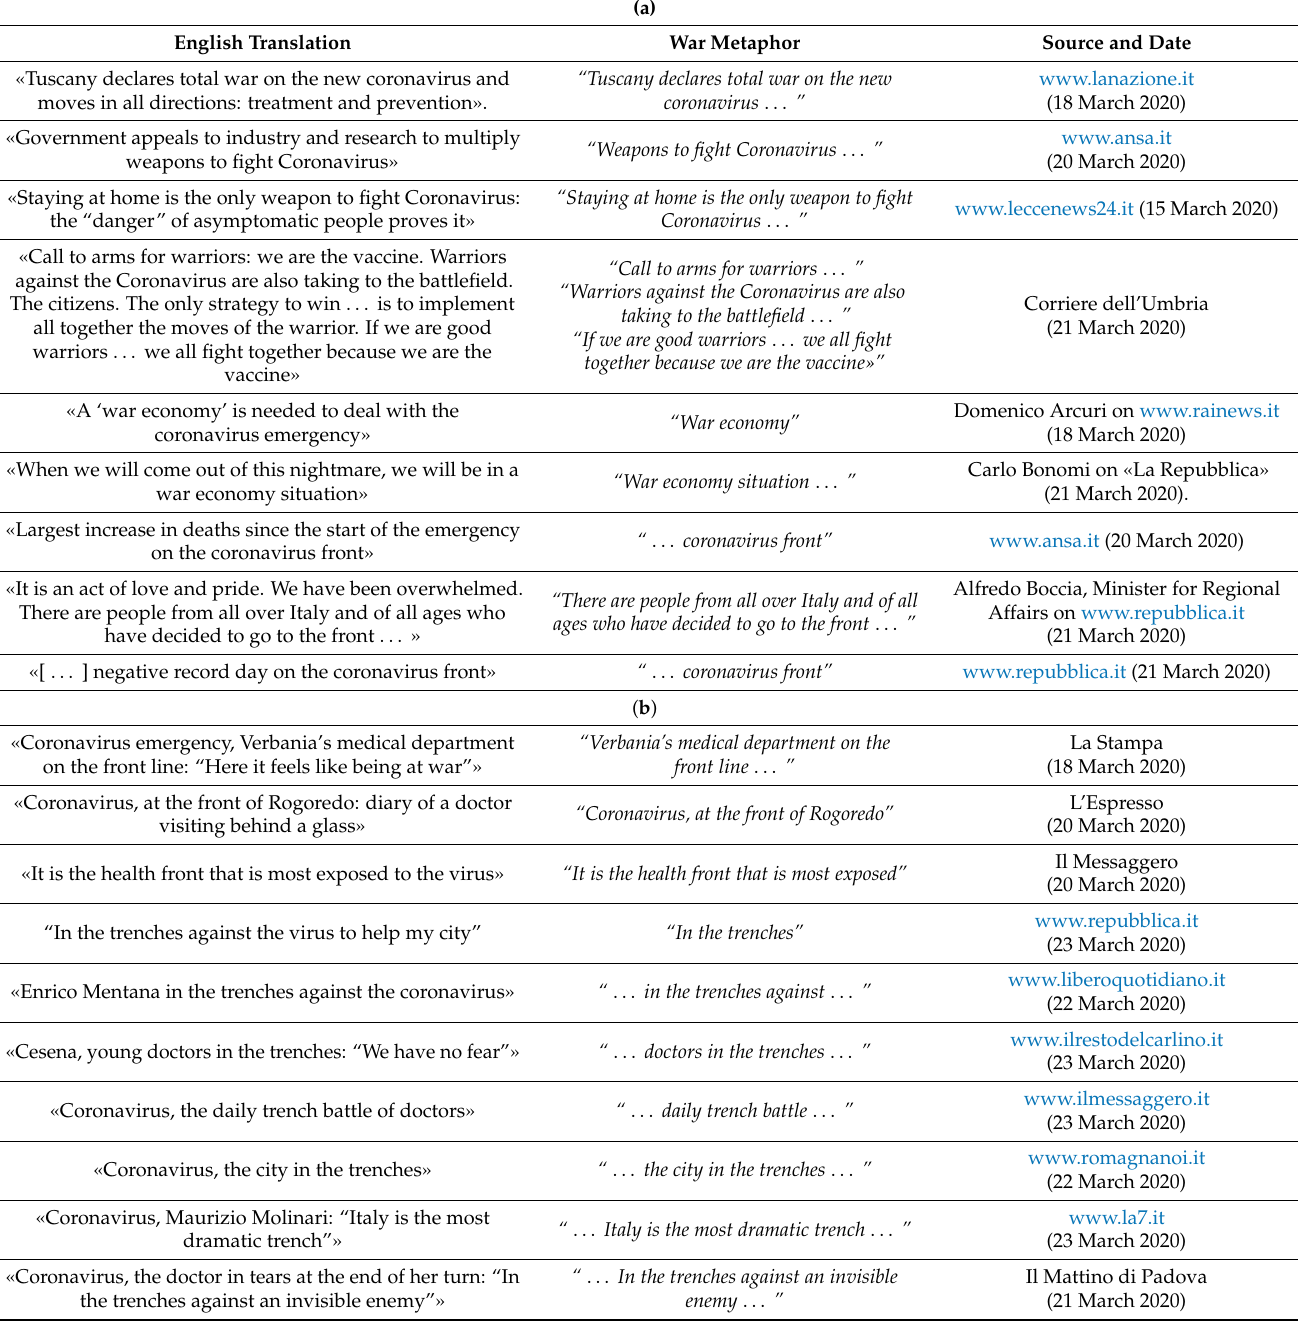
Table 2. ( a )—War, weapons, warriors: COVID-19 and war metaphors. ( b )—Battles and trenches: COVID-19 and war